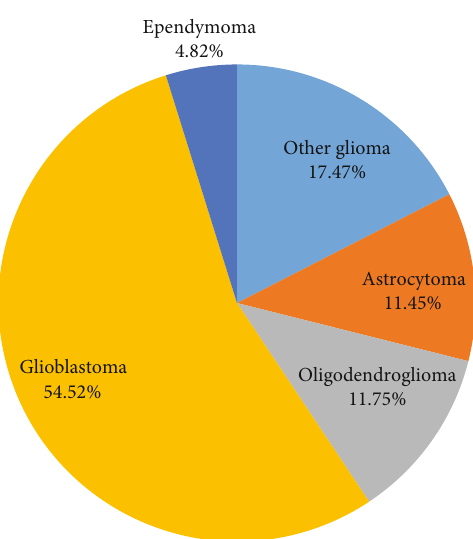
Figure 6: Distribution of all primary CNS gliomas by histologic subtype for adults ( > 18 years).